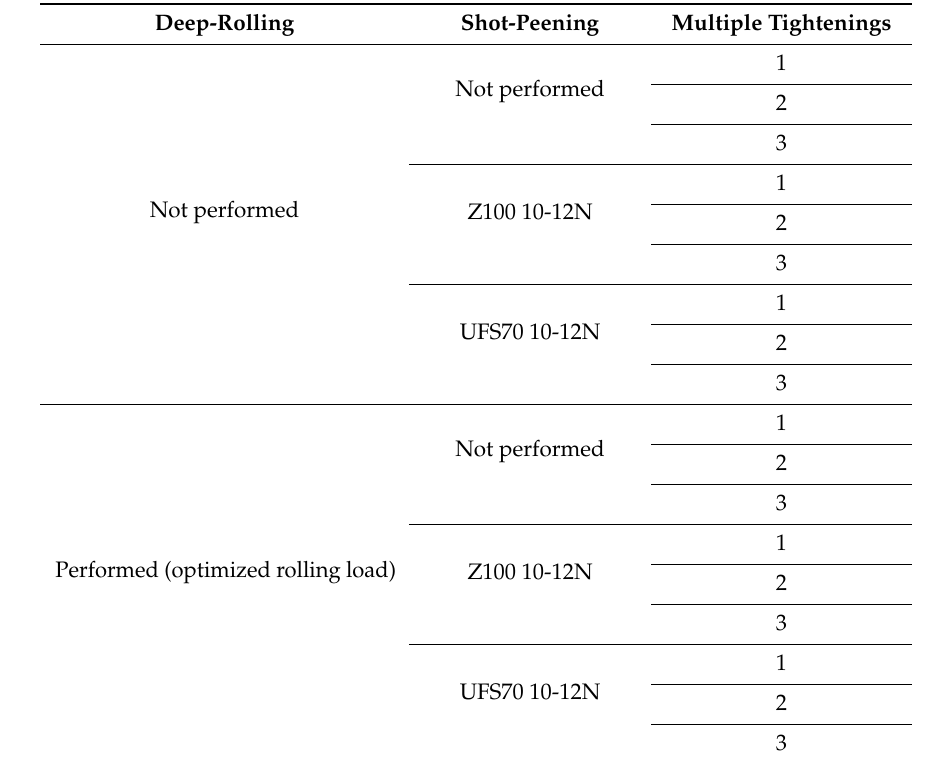
Table 1. Experimental